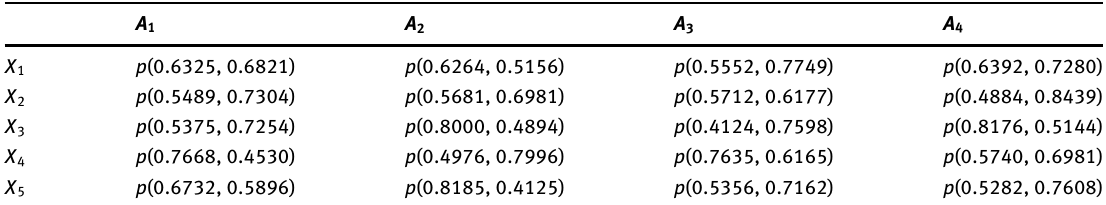
Table 9: Collective Pythagorean Fuzzy Decision Matrix R . A